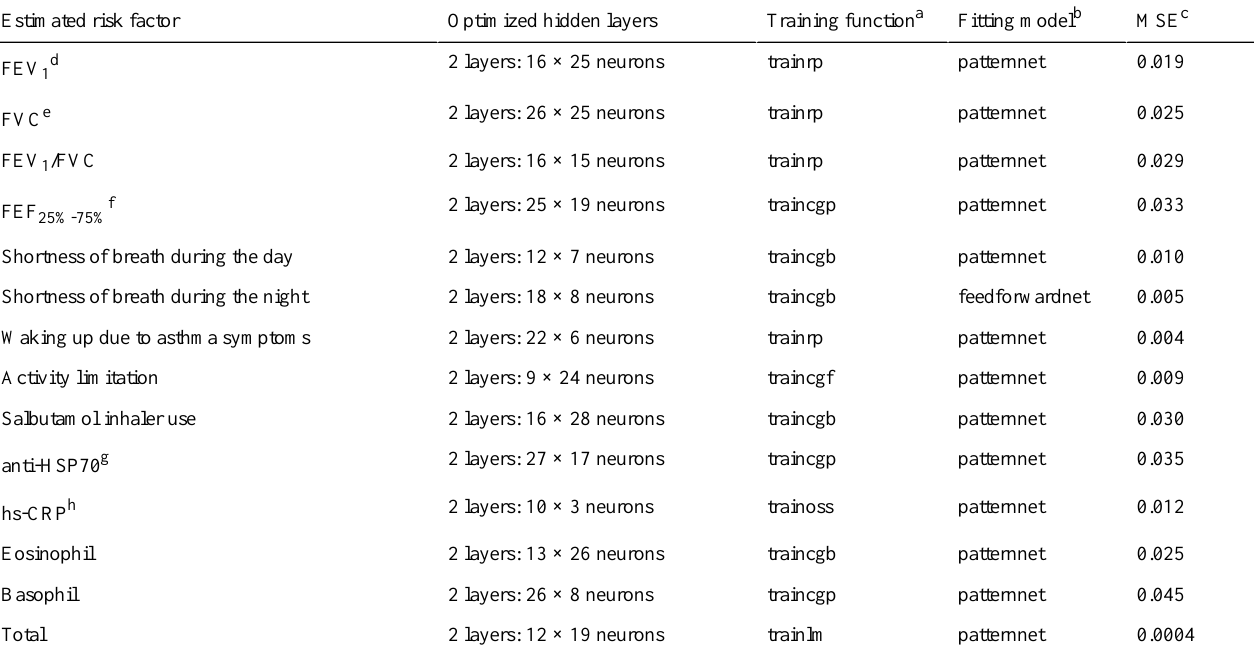
Table 4. Genetic algorithm–modified neural network optimization results for the best testing prediction of C sativus L